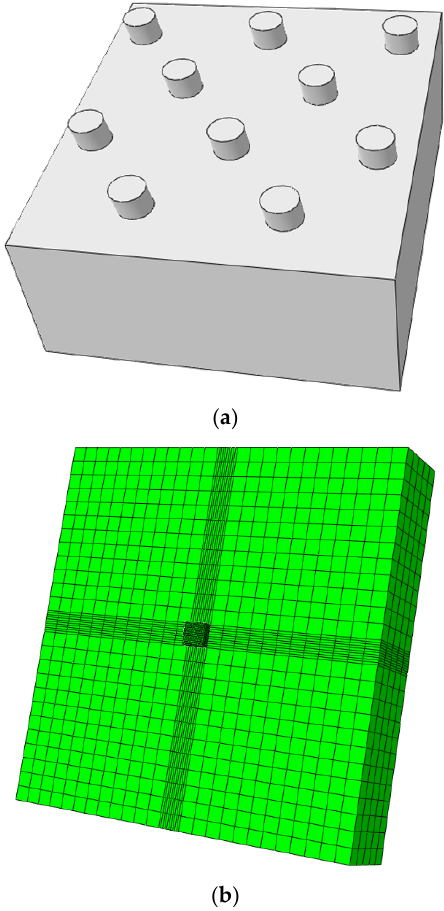
Figure 9. The 3D finite element model. ( a ) 3D finite element model of gravity anchor; ( b ) 3D finite element model of